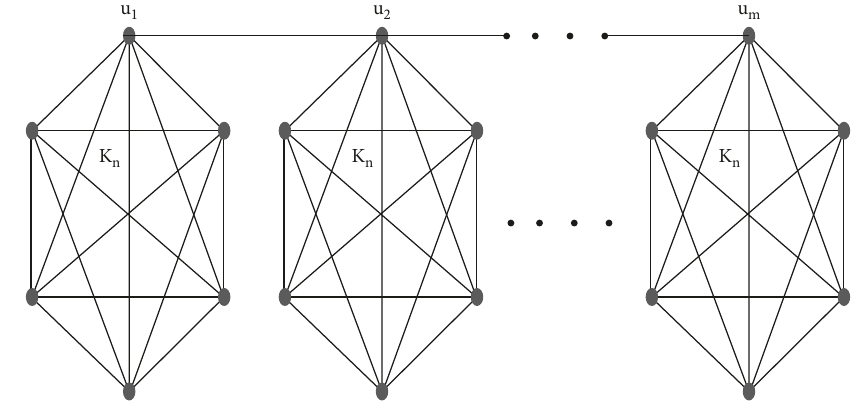
Figure 3: Bridge graph over complete graph K